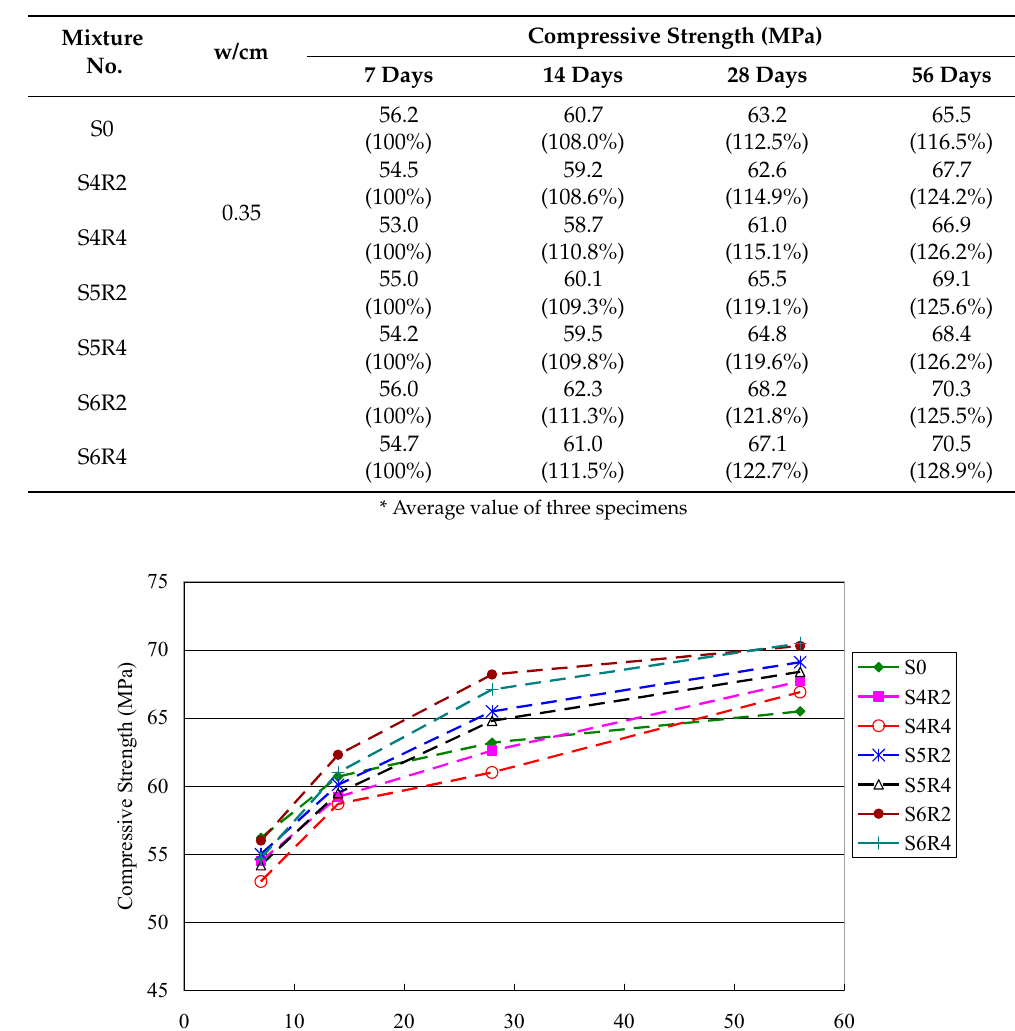
Table 3. The compressive strength of concrete cylinders.